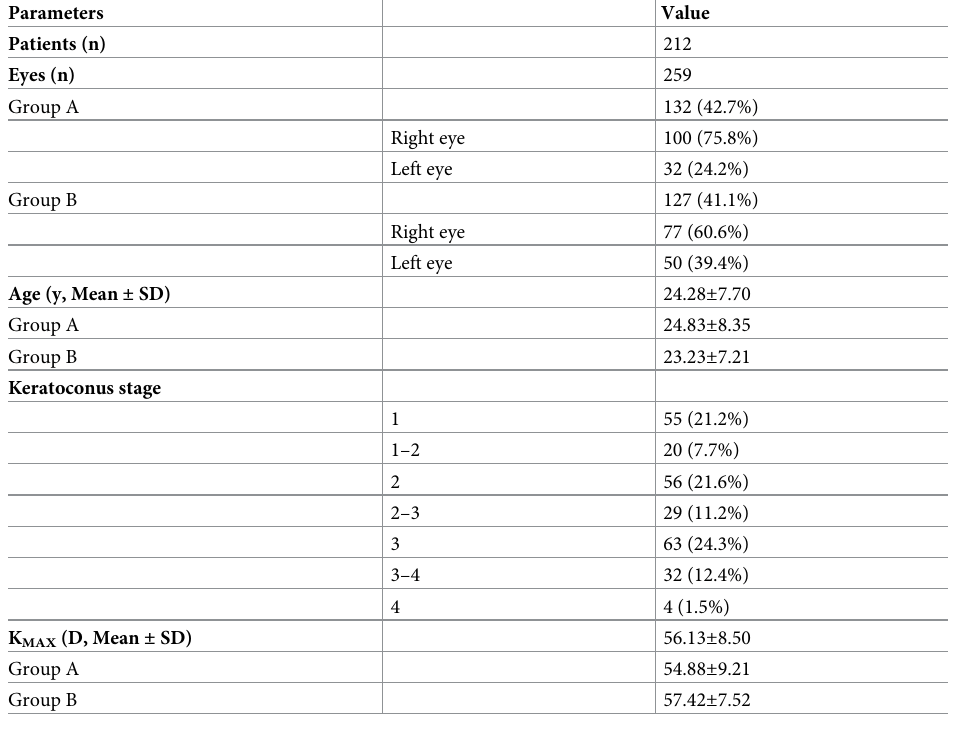
Table 1. Demographics of patients enrolled in the